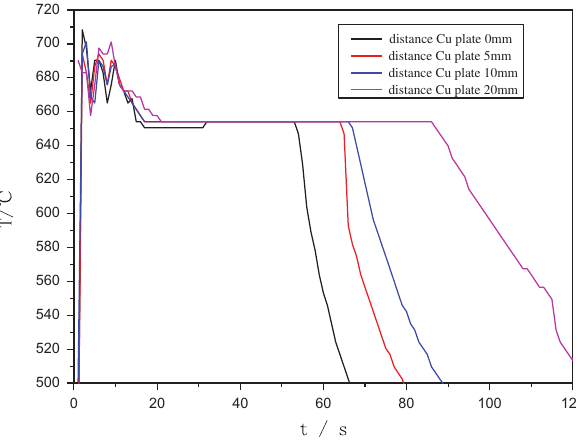
Figure 8: Cooling curves of horizontal pouring underpouringat 830°C, holding for 60 s and water injection cooling. cause the solidification of the liquid Al. In other words, the liquid Al was in contact with the solid Cu for a long time after pouring. During this period, the Cu atoms on the surface of the solid Cu constantly dissolved into the liquid Al to form an Al – Cu alloy melt (the transition layer) close